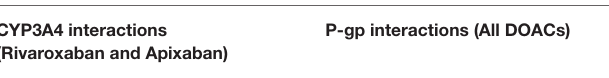
TABLE 3 | CYP3A4 and P-gp interaction with cancer drugs. Drug – drug interaction between Cancer Drugs With DOACs CYP3A4 interactions (Rivaroxaban and Apixaban)